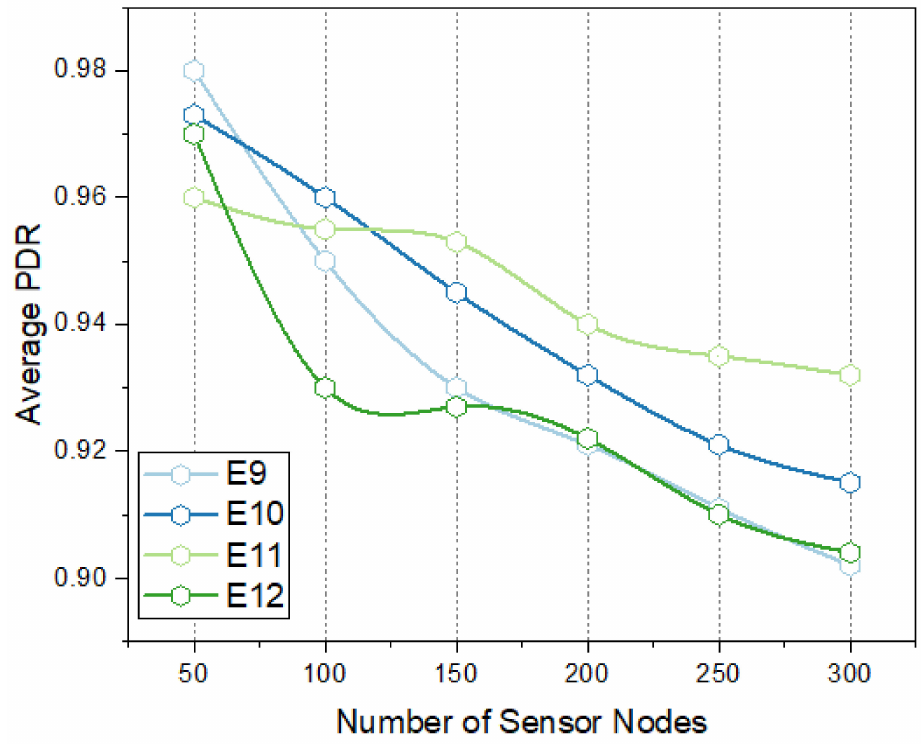
Figure 18. Energy-efficient routing schemes and Average